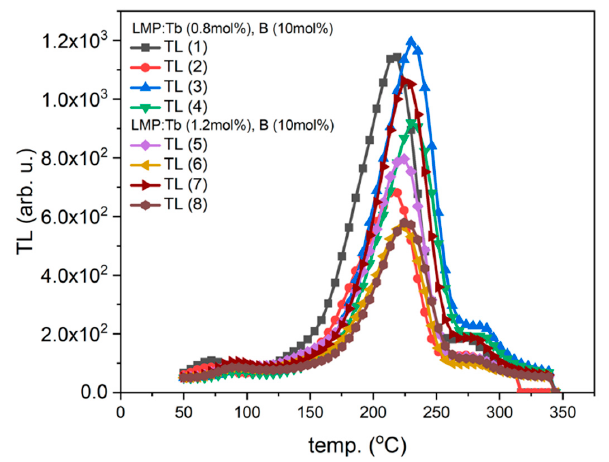
Figure 10. TL glow curves of LMP doped with 0.8-mol% Tb recorded for areas selected from the surface of the samples (indicated in Figure 7).